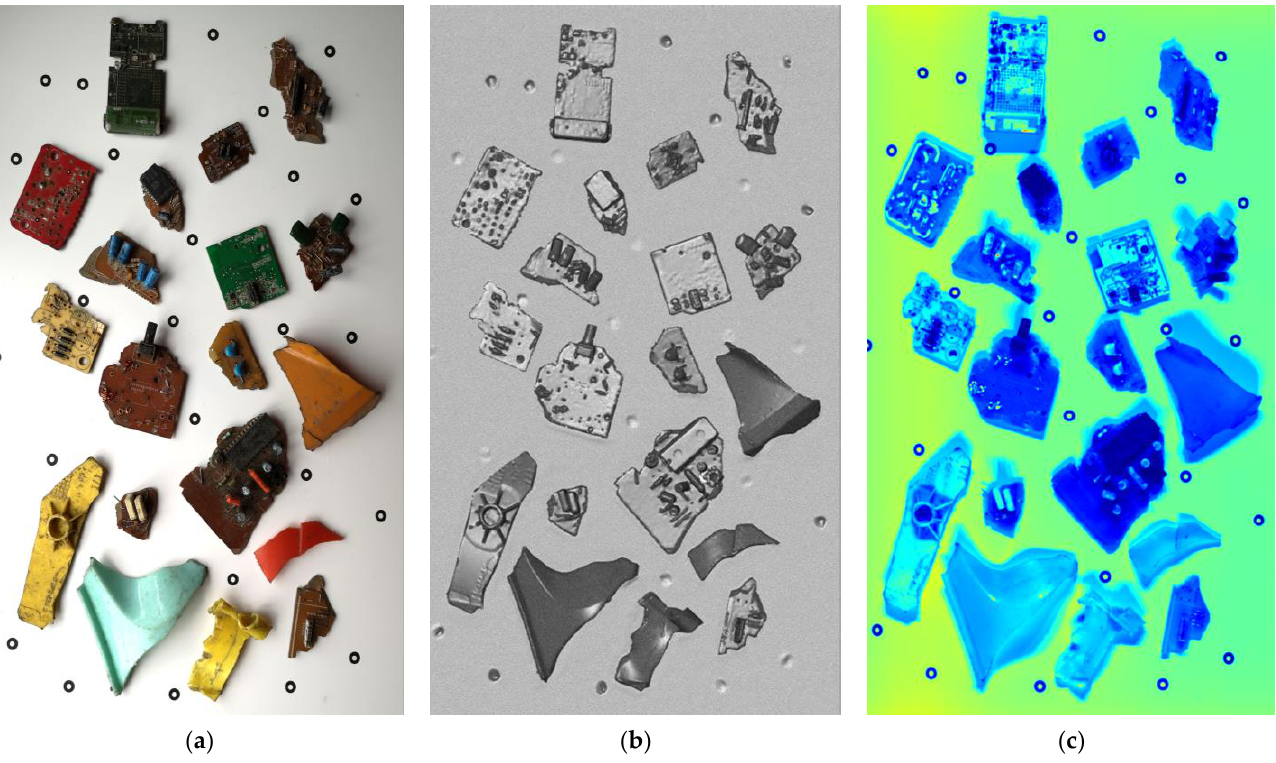
Figure 3. Acquired datasets of electronic waste consisting of waste plastics and PCBs: ( a ) RGB; ( b ) 3D point cloud with a resolution of 0.5 mm and a depth accuracy of 0.05 mm; ( c ) HSI with a resolution of 636 × 1118 pixels and 224 bands in the wavelength range from 900 nm to 1700 nm.